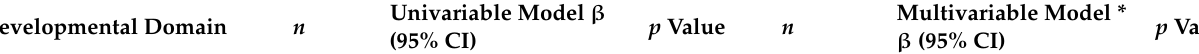
Table 3. Univariable and multivariable linear regression results for the associations between maternal and child hemoglobin levels and developmental scores at 15